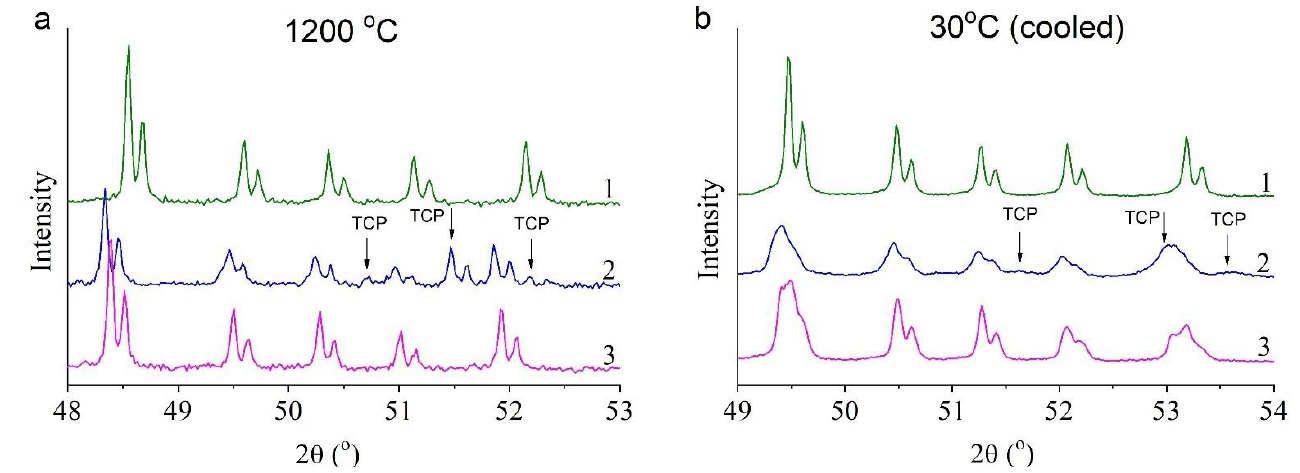
Figure 9. XRPD patterns of samples 0.0Cu ( 1 ), 0.5Cu-Ca ( 2 ), and 0.5Cu-OH ( 3 ) at 1200 °C ( a ) and after cooling to 30 °C ( b ).